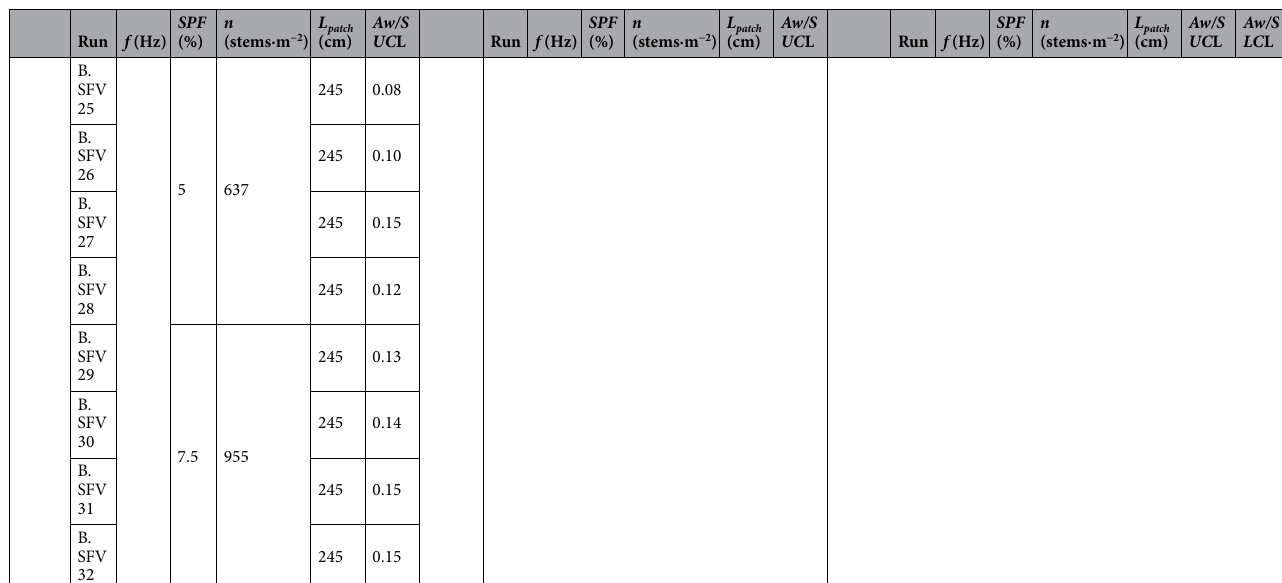
Table 3. Summary of the experimental conditions tested by Zhang et al. 20 , Barcelona et al. 29 and Pujol et al. 16 .